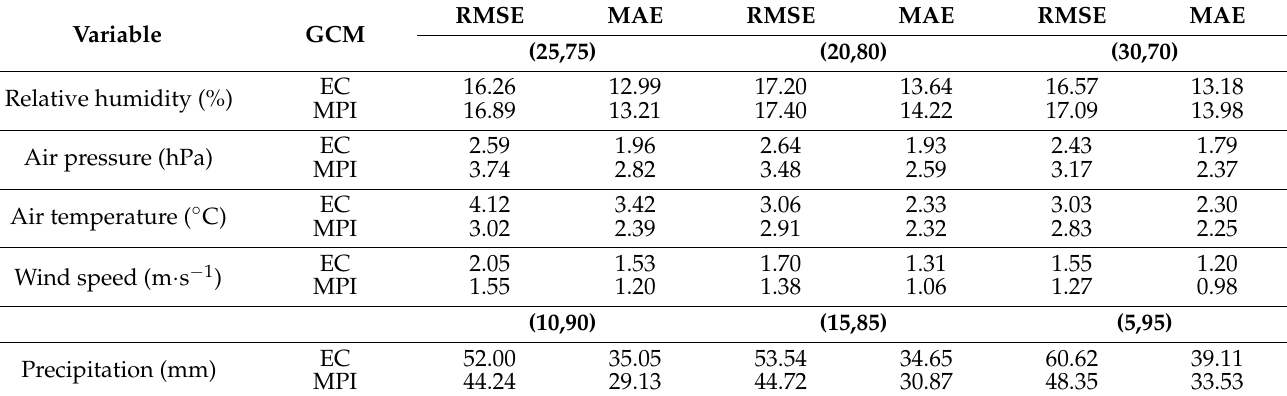
Table A2. RMSE and MAE values measured at Naqu between the calibrated results and the monthly observations in the 1985–1999 period using different pairs of quantiles: (25,75), (20,80), (30,70), except for precipitation where (10,90), (15,85) and (5,95) were compared. N = 180.